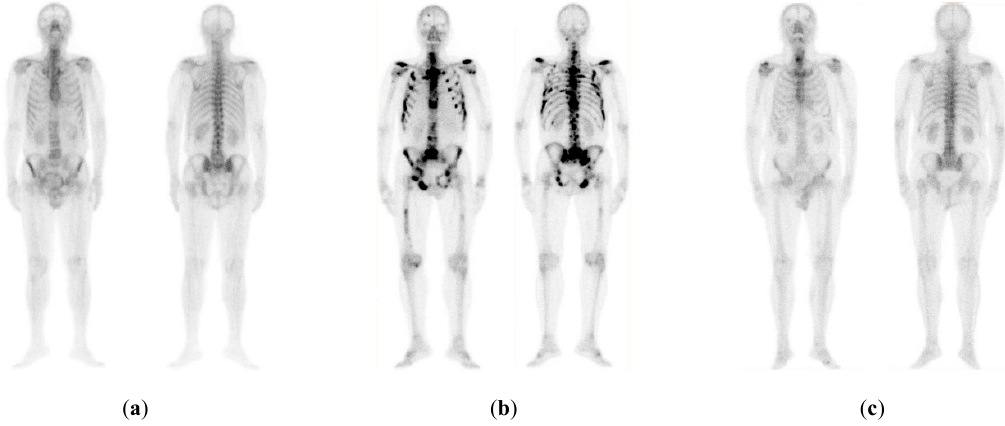
Figure 1. Examples of the three categories of prostate cancer (P-Ca) patients: ( a ) normal (metastasis absent); ( b ) malignant (metastasis present); ( c ) benign-degenerative (no metastasis, but image includes degenerative lesions/changes) [14].